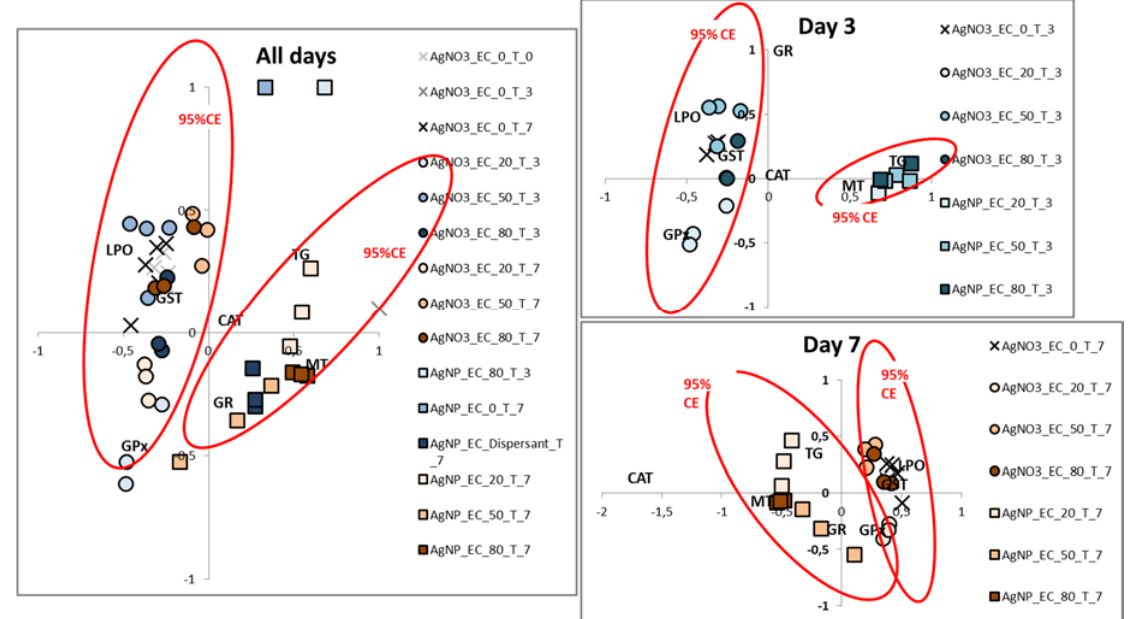
Figure 2: Correspondence analysis of data from Enchytraeus crypticus exposed to AgNP (Ag NM300K) [60 (EC 20 ), 170 (EC 50 ) and 225 (EC 80 ) mg Ag/kg soil] and AgNO 3 [45 (EC 20 ), 60 (EC 50 ) and 96 (EC 80 ) mg Ag/kg soil], as sampled at 0–3–7 days (designated T_0, T_3 and T_7), in terms of catalase (CAT), glutathione peroxidase (GPx), glutathione S-transferase (GST), glutathione reductase (GR), total glutathione (TG), metallothionein (MT) and lipid peroxidation (LPO). CE: confidence